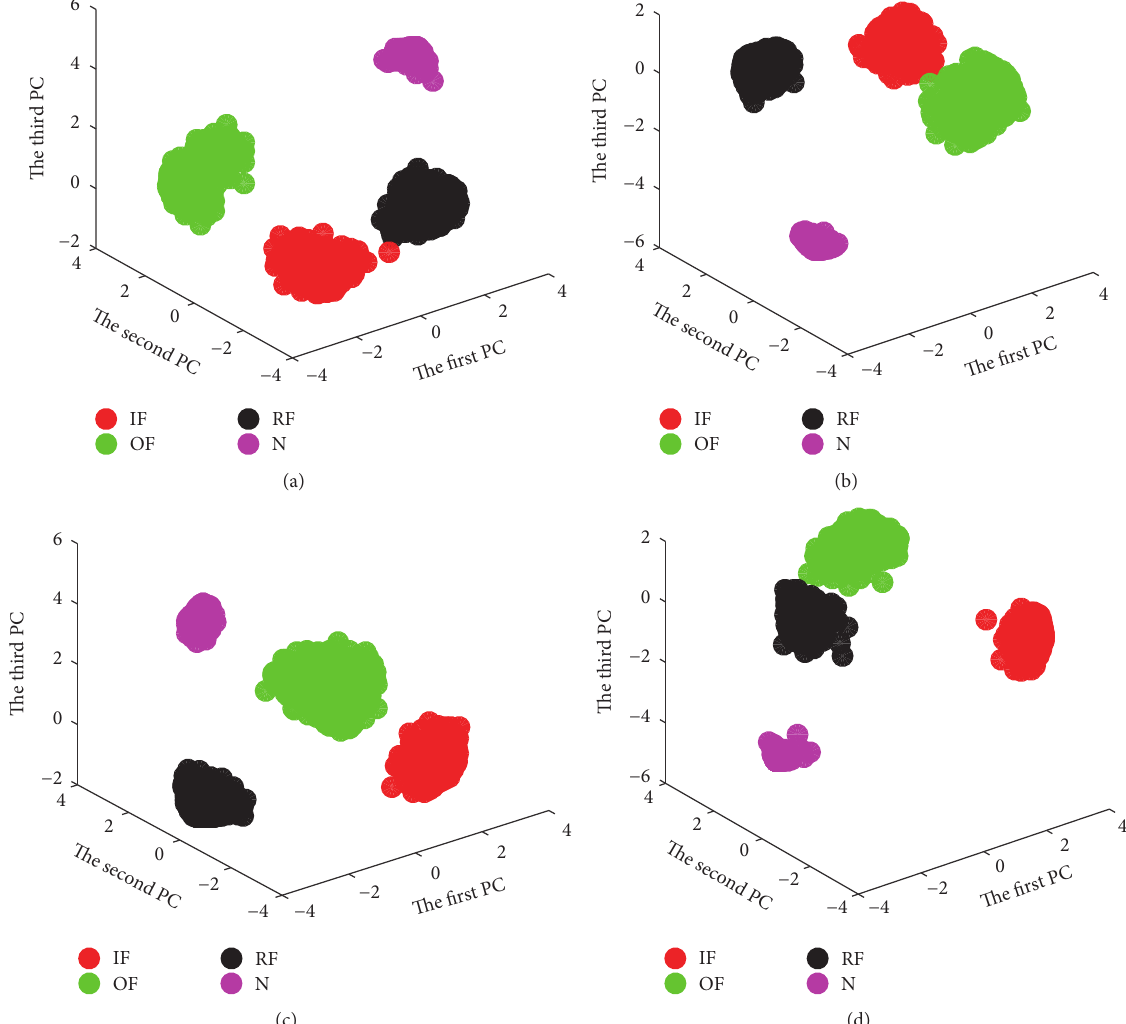
Figure 8: Scatter plots of principal components for the feature of fault classification; (a)–(d) represent four modes: corresponding to Mode 1, Mode 2, Mode 3, and Mode 4, respectively.